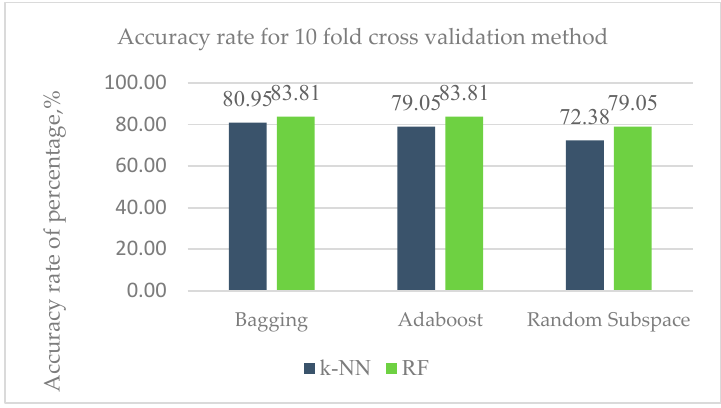
Figure 19. Accuracy rate of Dataset 2 with holdout method.